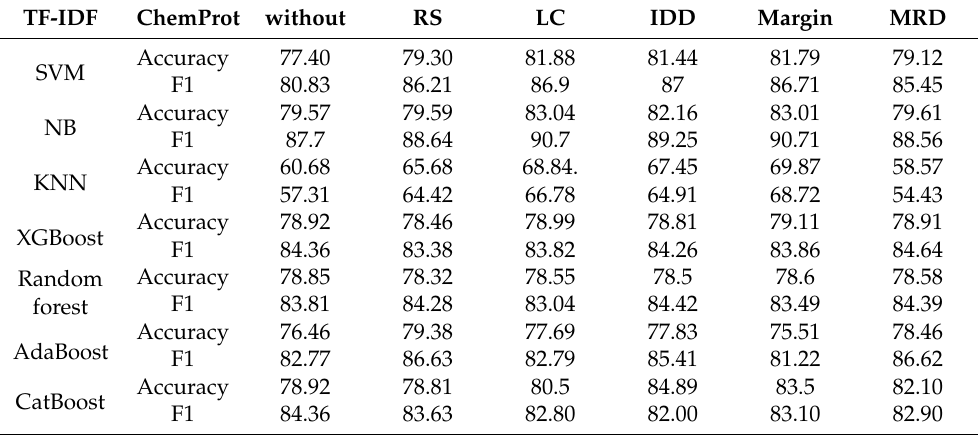
Table 3. Comparison of results with and without AL methods (TF-IDF) for ChemProt dataset.